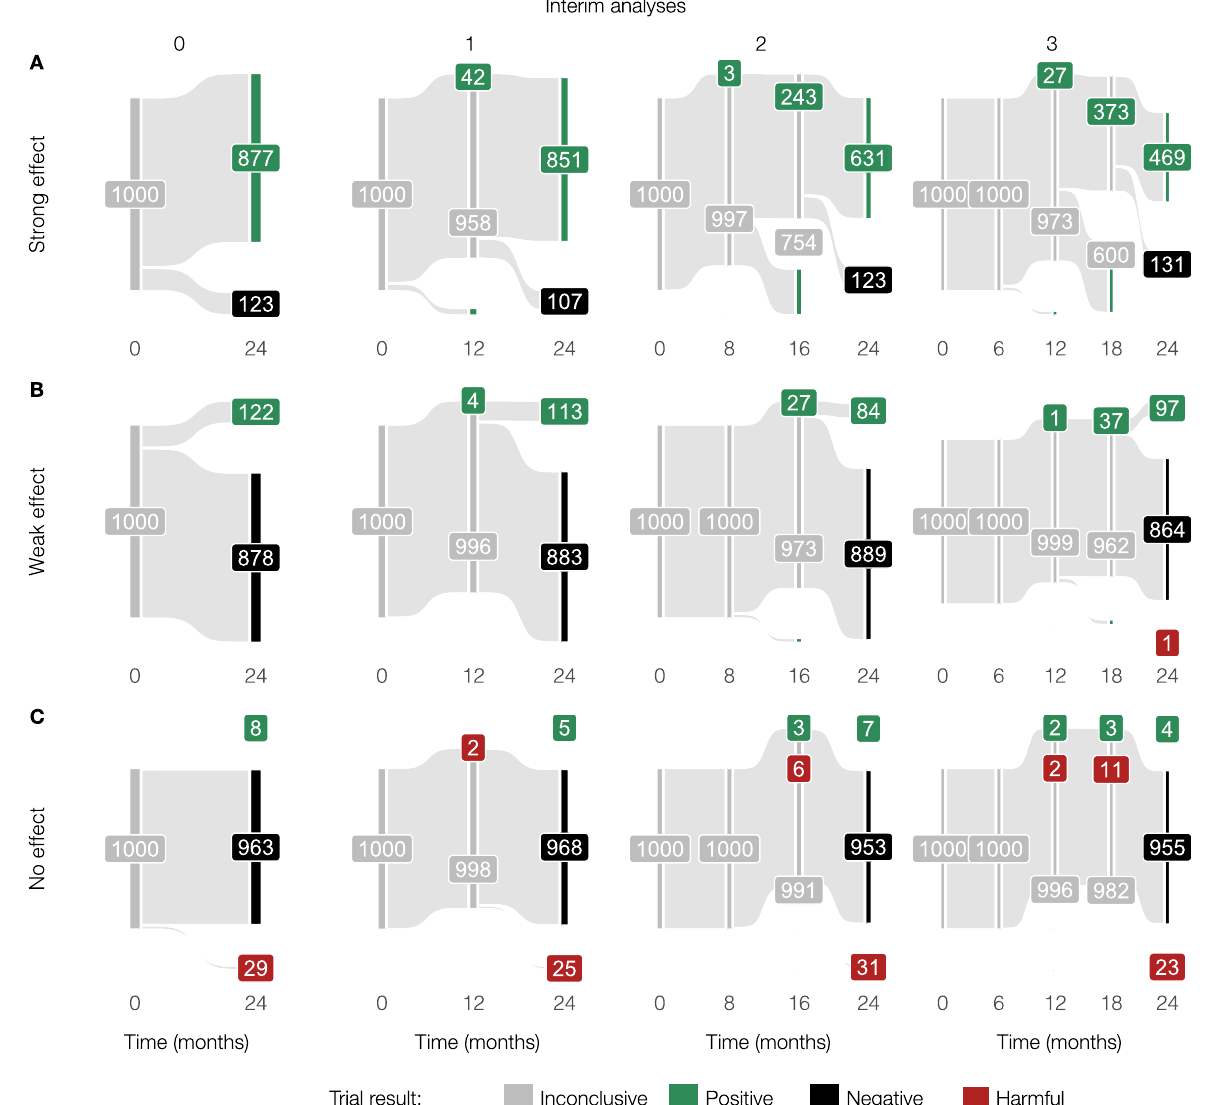
Fig. 7 | A priori scrutiny of the interim analysis plan to evaluate possible advantages and disadvantages of timed additional analyses during the trial. A In the case of immunotherapy with a potent effect, in silico trials help develop a rationale for the timing of the interim analyses. In these simulations, while an interim analysisat12 months might not add value to the trial, analyses after16 and 18months,respectively,haveaprobabilityofapproximately25%and40%toleadto early stopping with a positive result. B Multiple interim analyses can reduce the probability of con fi rming the desired treatment effect in case of a weak